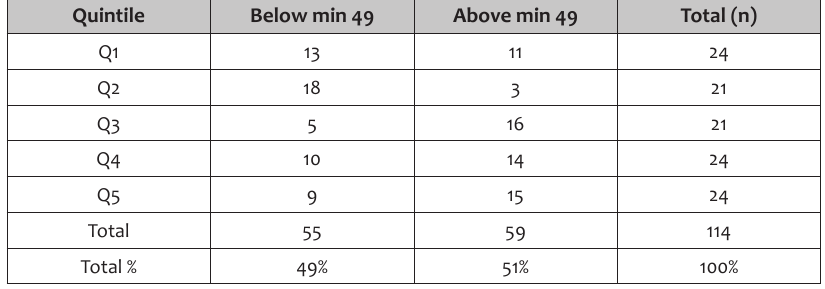
Table 3: Below and above minimum achievement of learners according to quintile